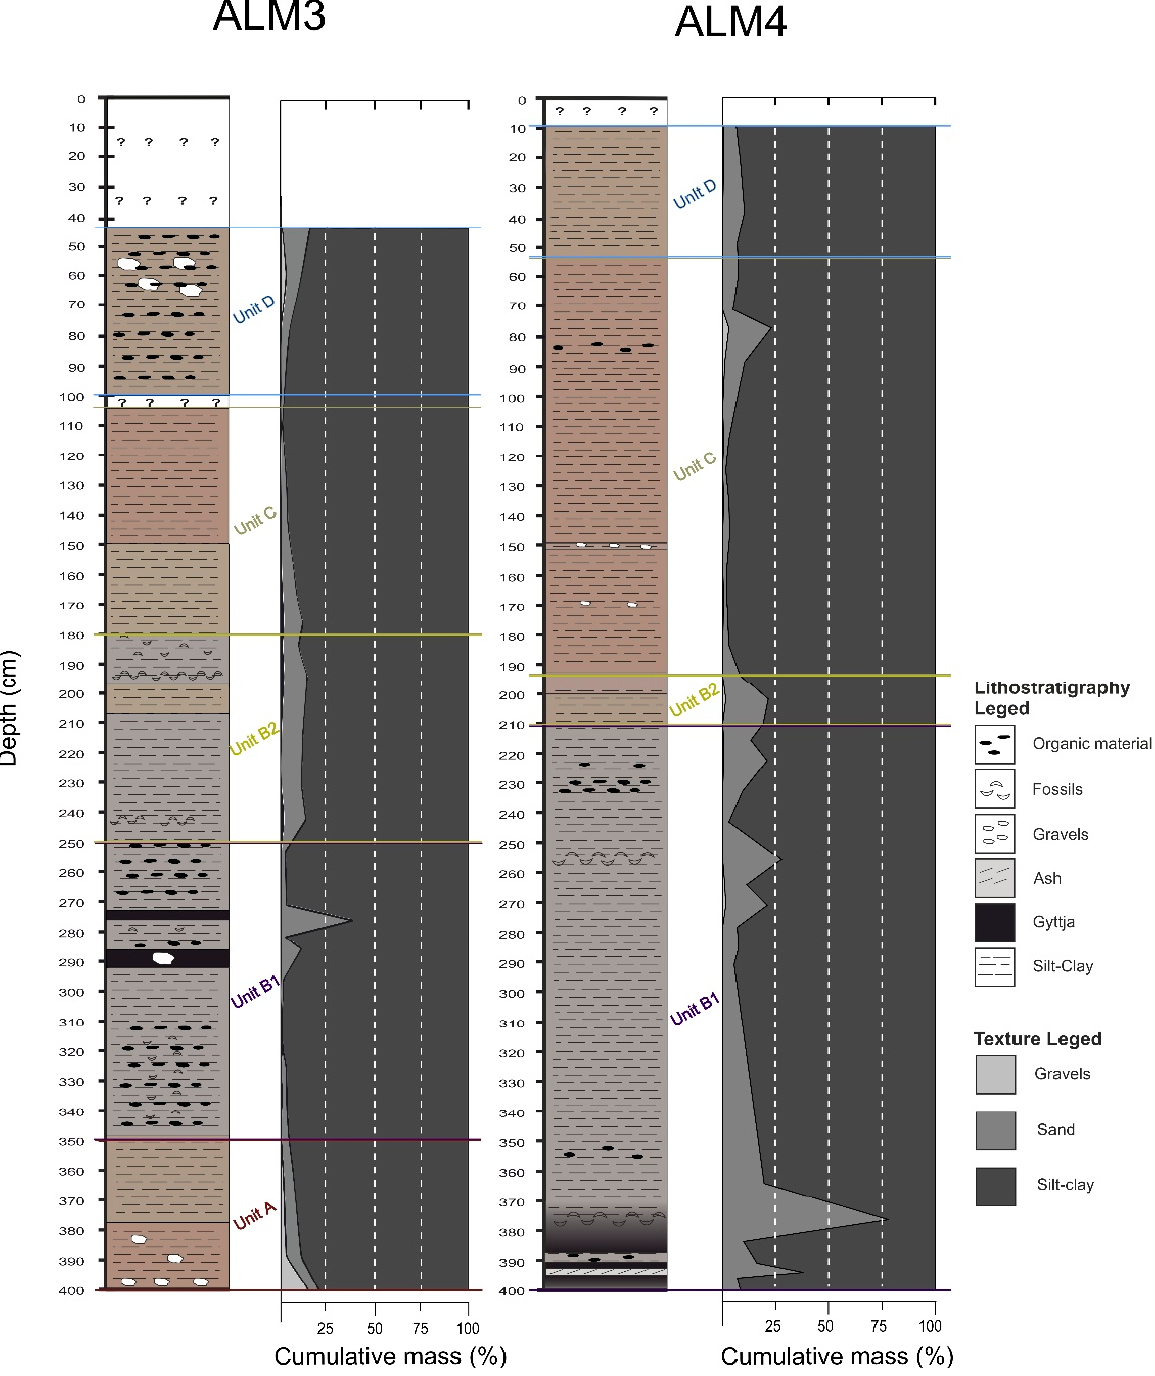
Figure 2. Cores ALM3 and ALM4 lithostratigraphy along with the corresponding sediment texture graphs. The sedimentological units are indicated on each core. The question marks (?) are indicative of disturbed material during coring.